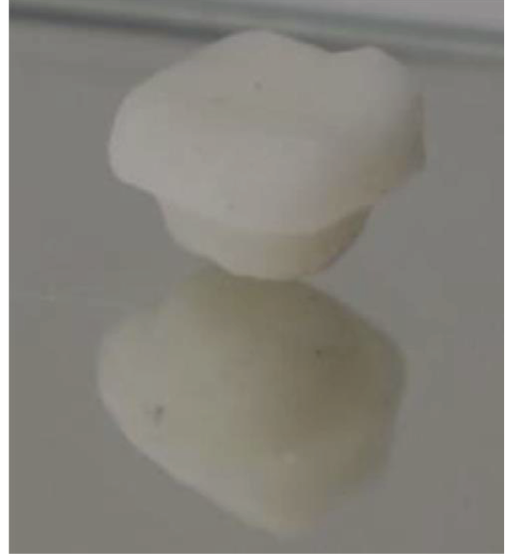
Figure 6: Aspect of the provisional restoration.